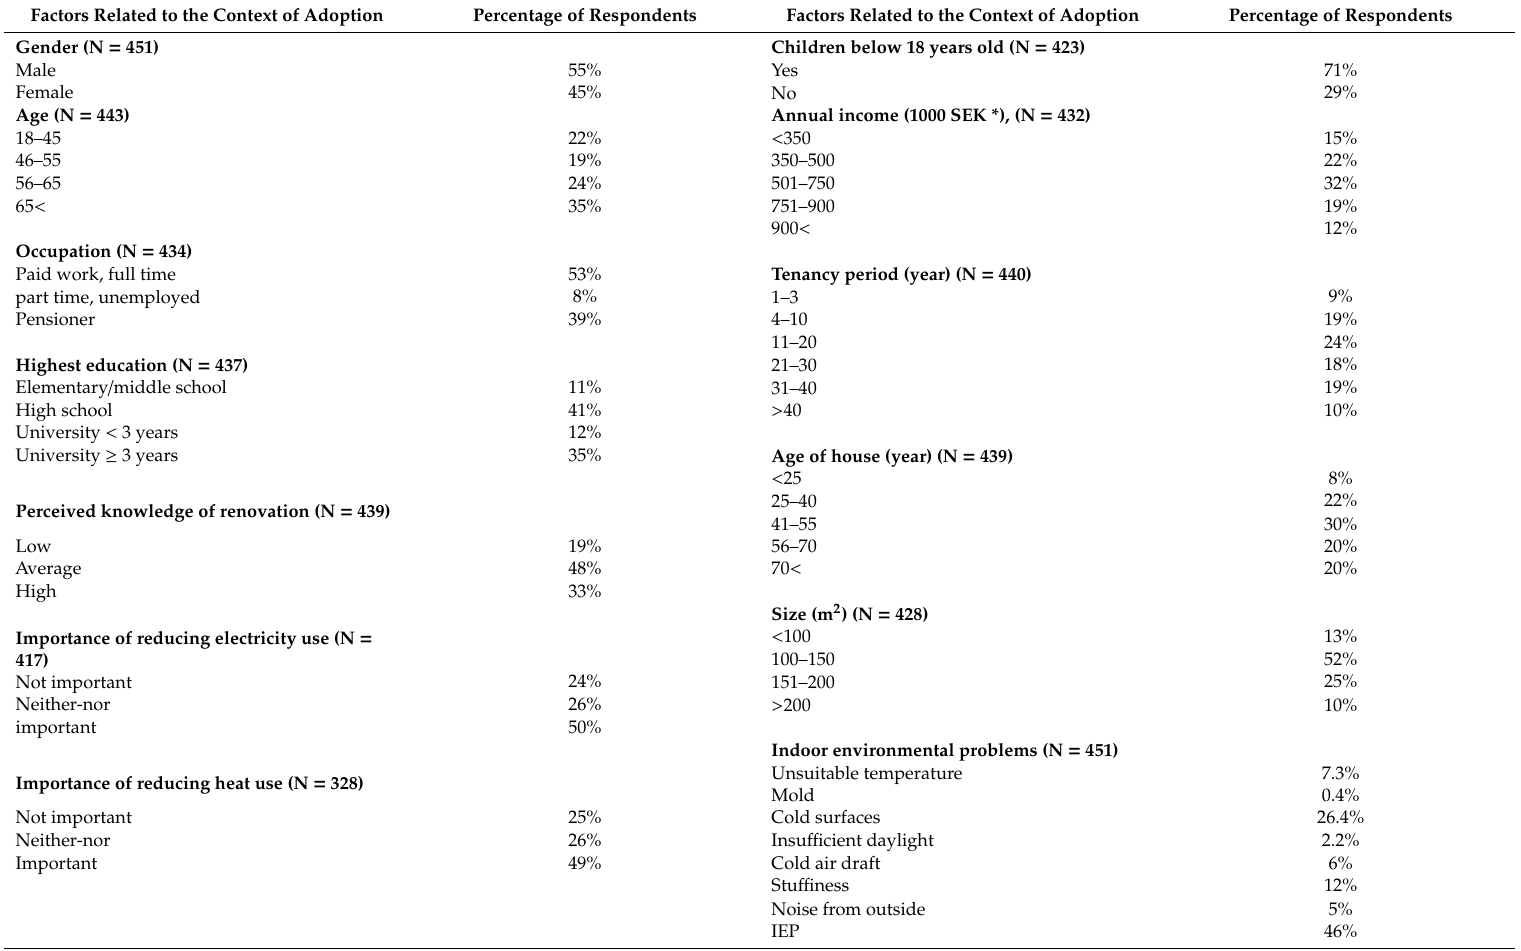
Table 1. Summary statistics of responses to the